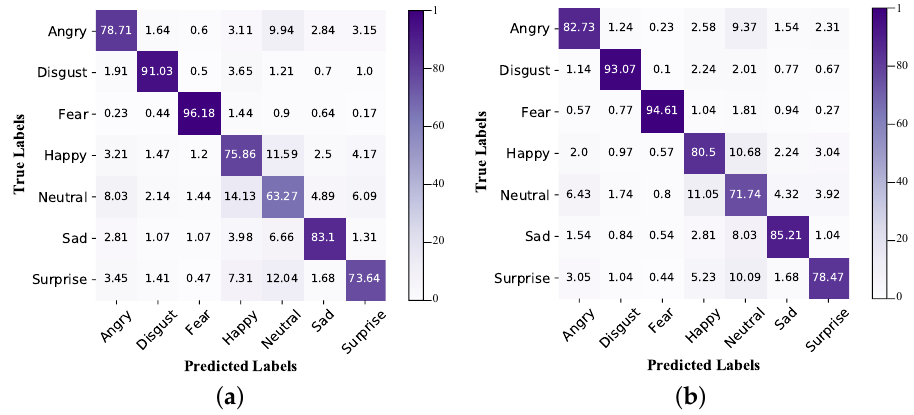
Figure 11. Confusion matrices of SE + CA + AA and SE + CA + ER + AA on the CAER benchmark. ( a ) SE + CA + AA; ( b ) SE + CA + ER +